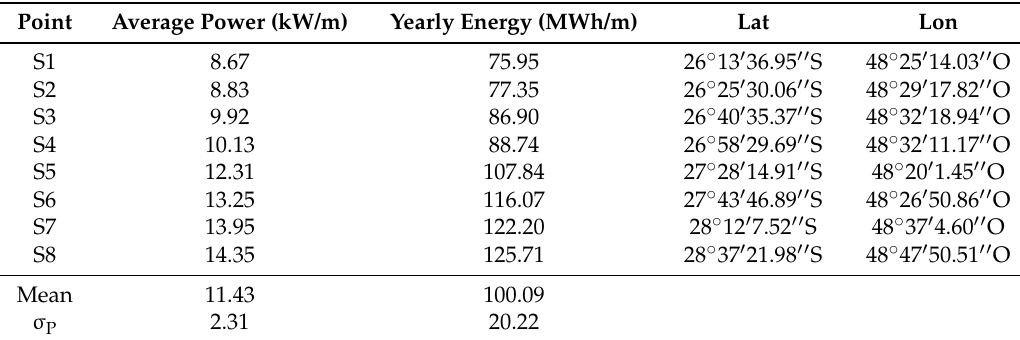
Table 5. Average wave power and yearly energy per meter of wave front at each study